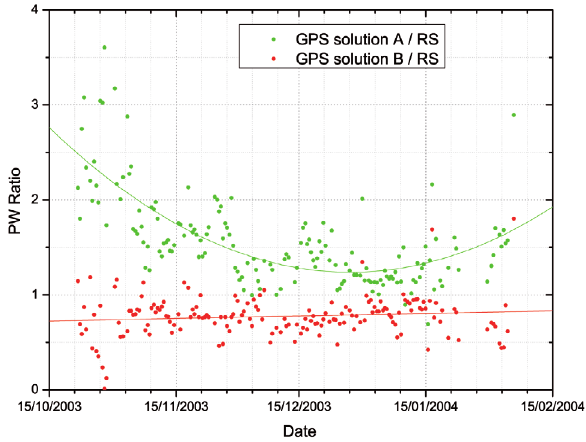
Figure 9. Hourly precipitable water time series derived from GPS solution A (black) and solution B (red). Blue squares, the precip- itable water determined every 12 h by the radiosounding meas-